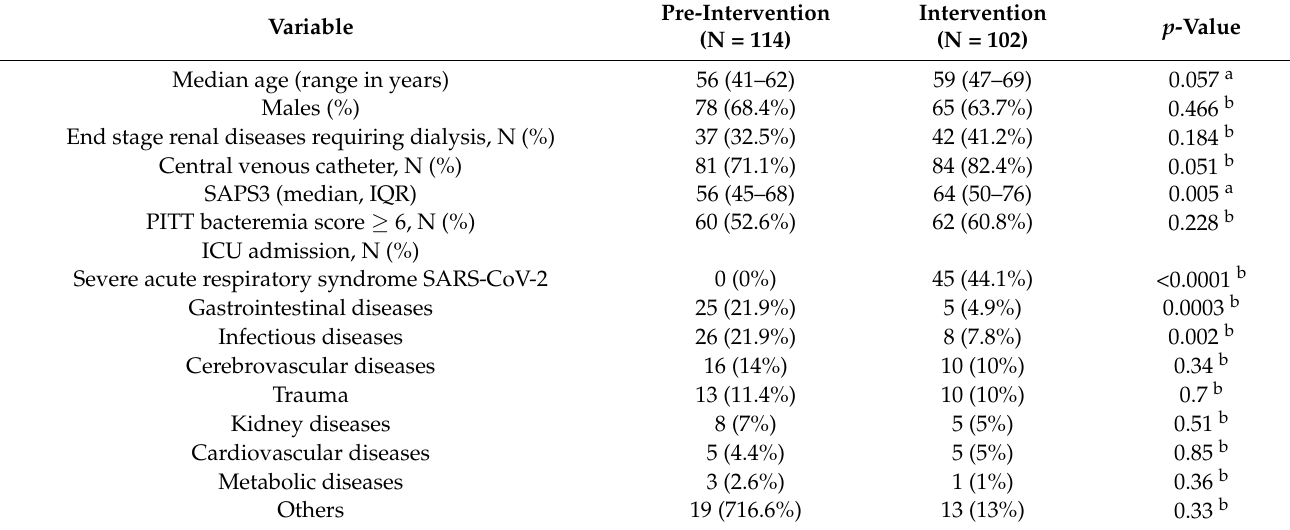
Table 1. Baseline patient characteristics, resistance genes detection, and empirical antimicrobial therapy of